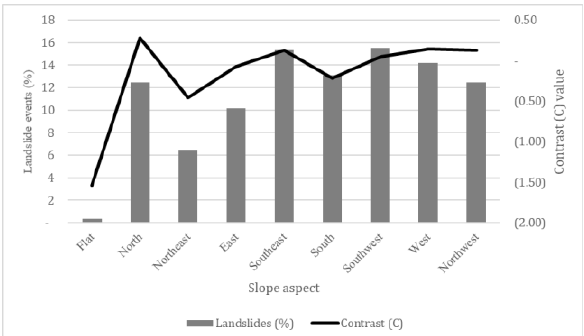
Figure 5 Landslide distribution (%) (left vertical axis) and contrast value (right vertical axis) in different slope aspects.